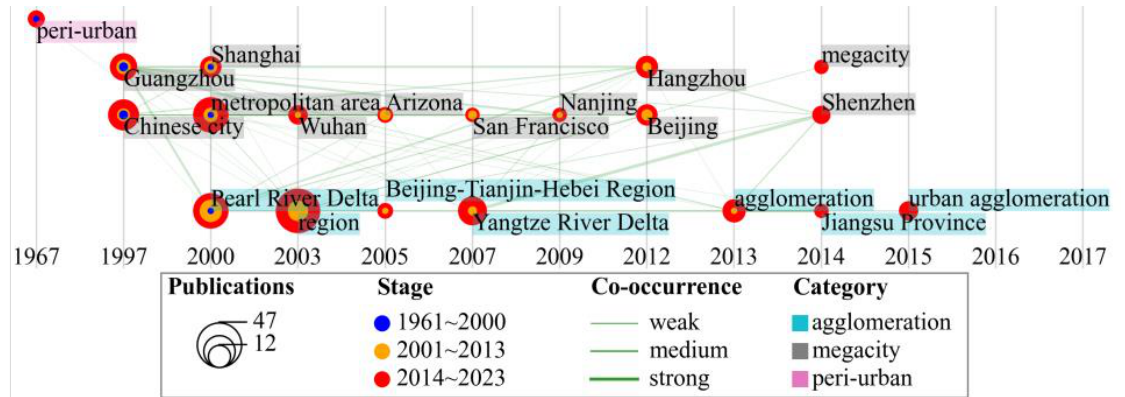
Figure 8. Development of themes indicating “study area”.